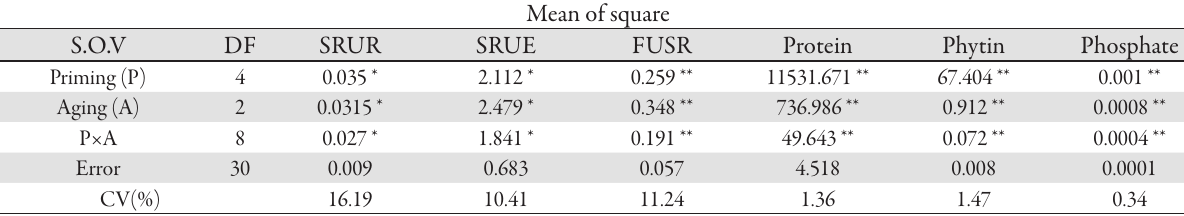
Tab. 2. Analysis of variance for common bean grain biochemical